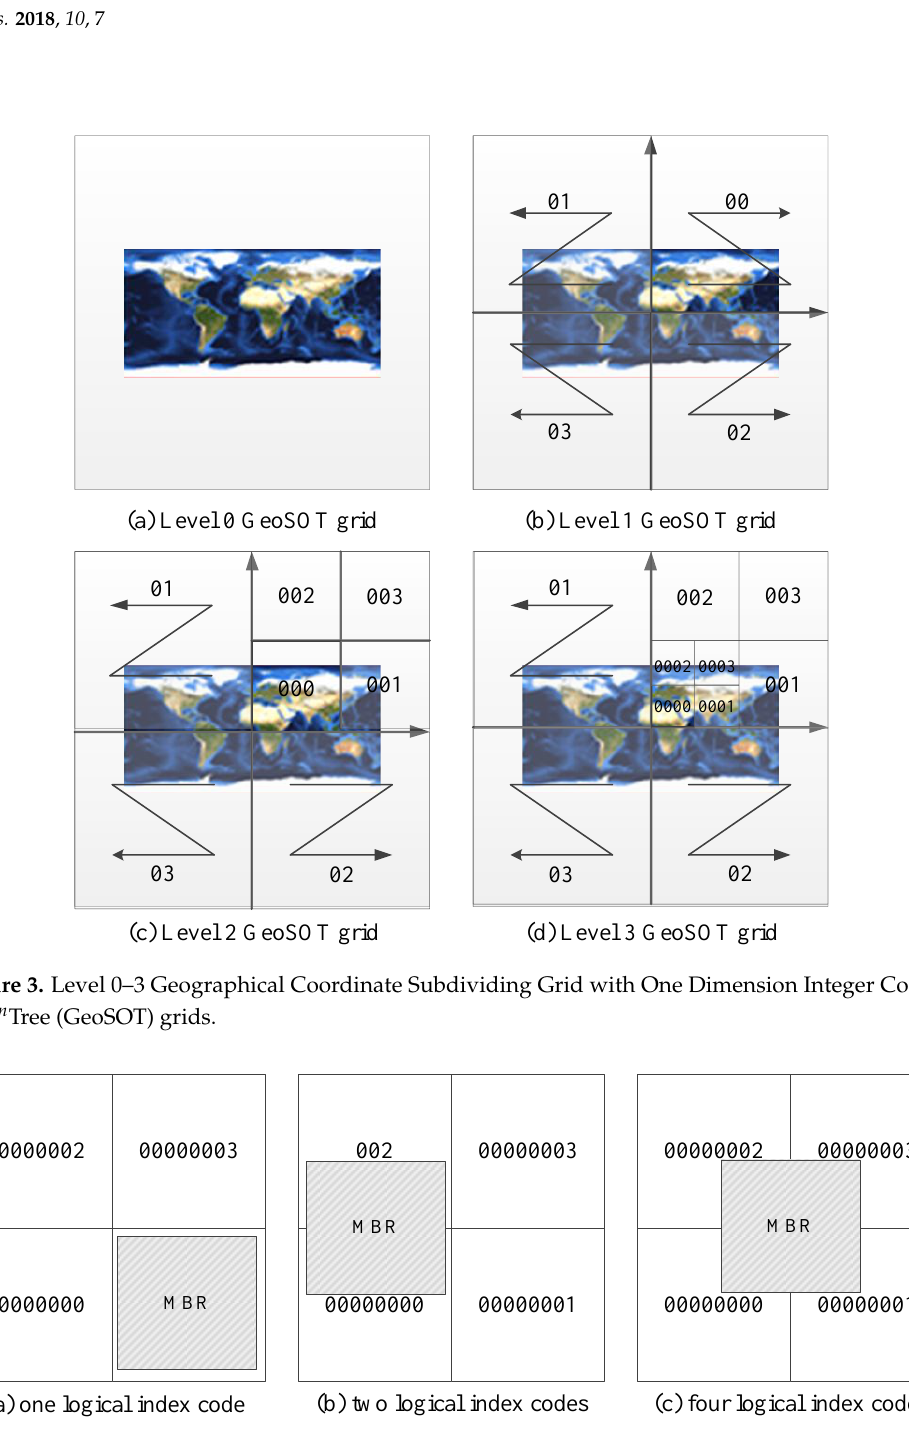
Figure 4. Three cases with respect to the logical partition index code. MBR: minimum bounding